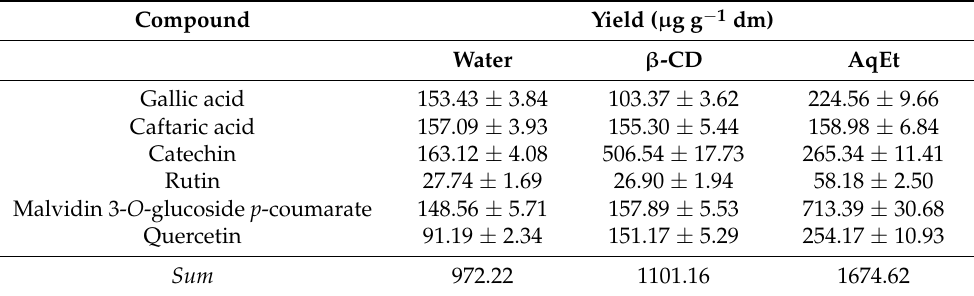
Table 4. Quantitative data on the recovery of major polyphenols of RGP, recovered with the different extraction media tested. Values reported represent means ± standard deviation ( n =